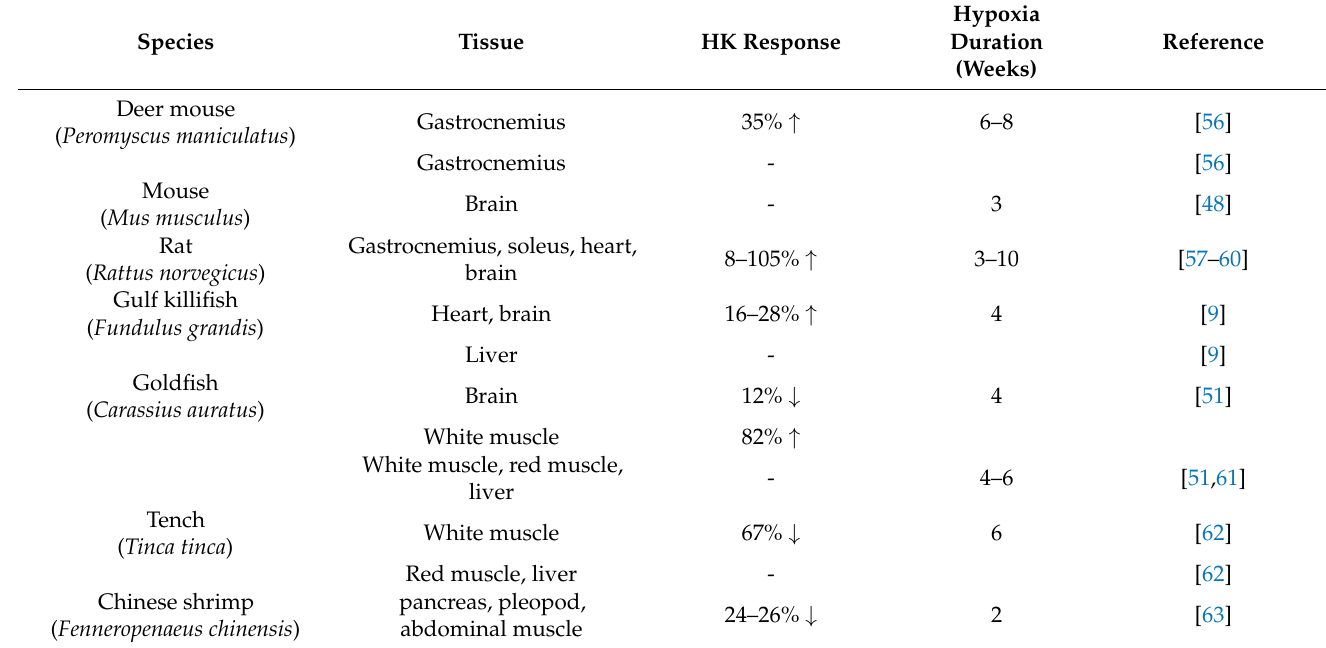
Table 2. Effects of chronic hypoxia (minimum 1 week) on the maximal activity of hexokinase (HK) in various animals.